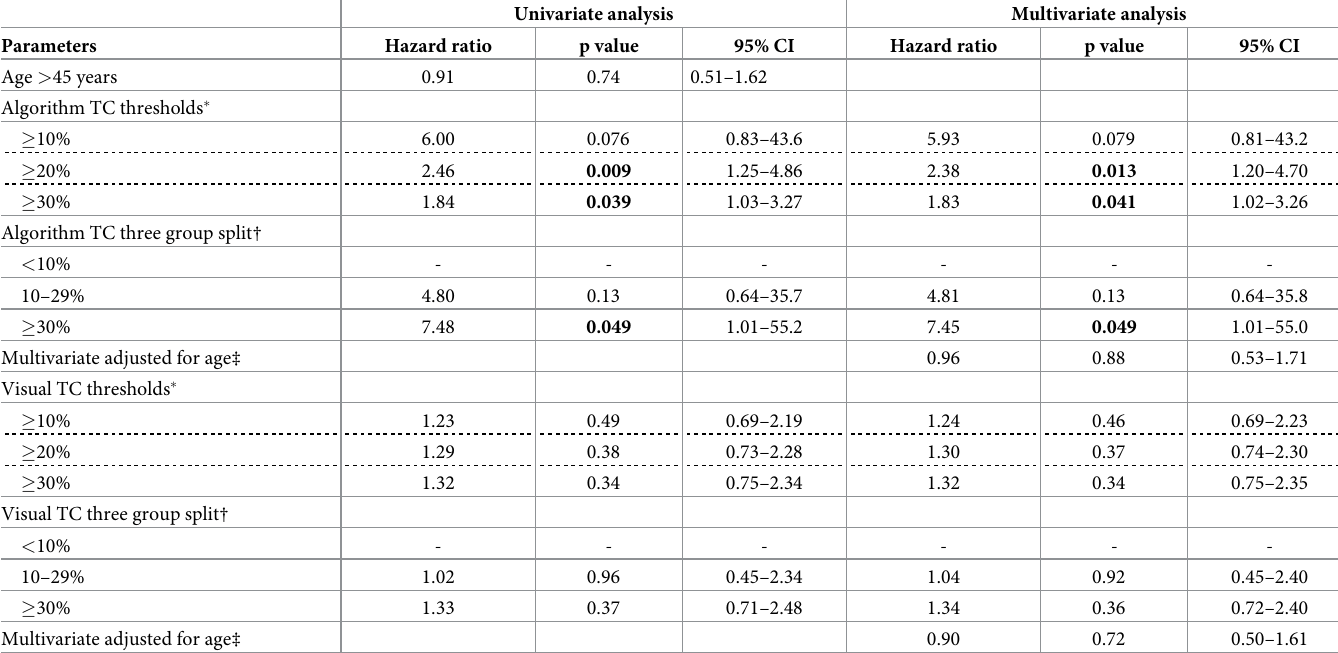
Table 3. Cox univariate and multivariate regression analysis for relapse-free survival (RFS) among patients with papillary thyroid